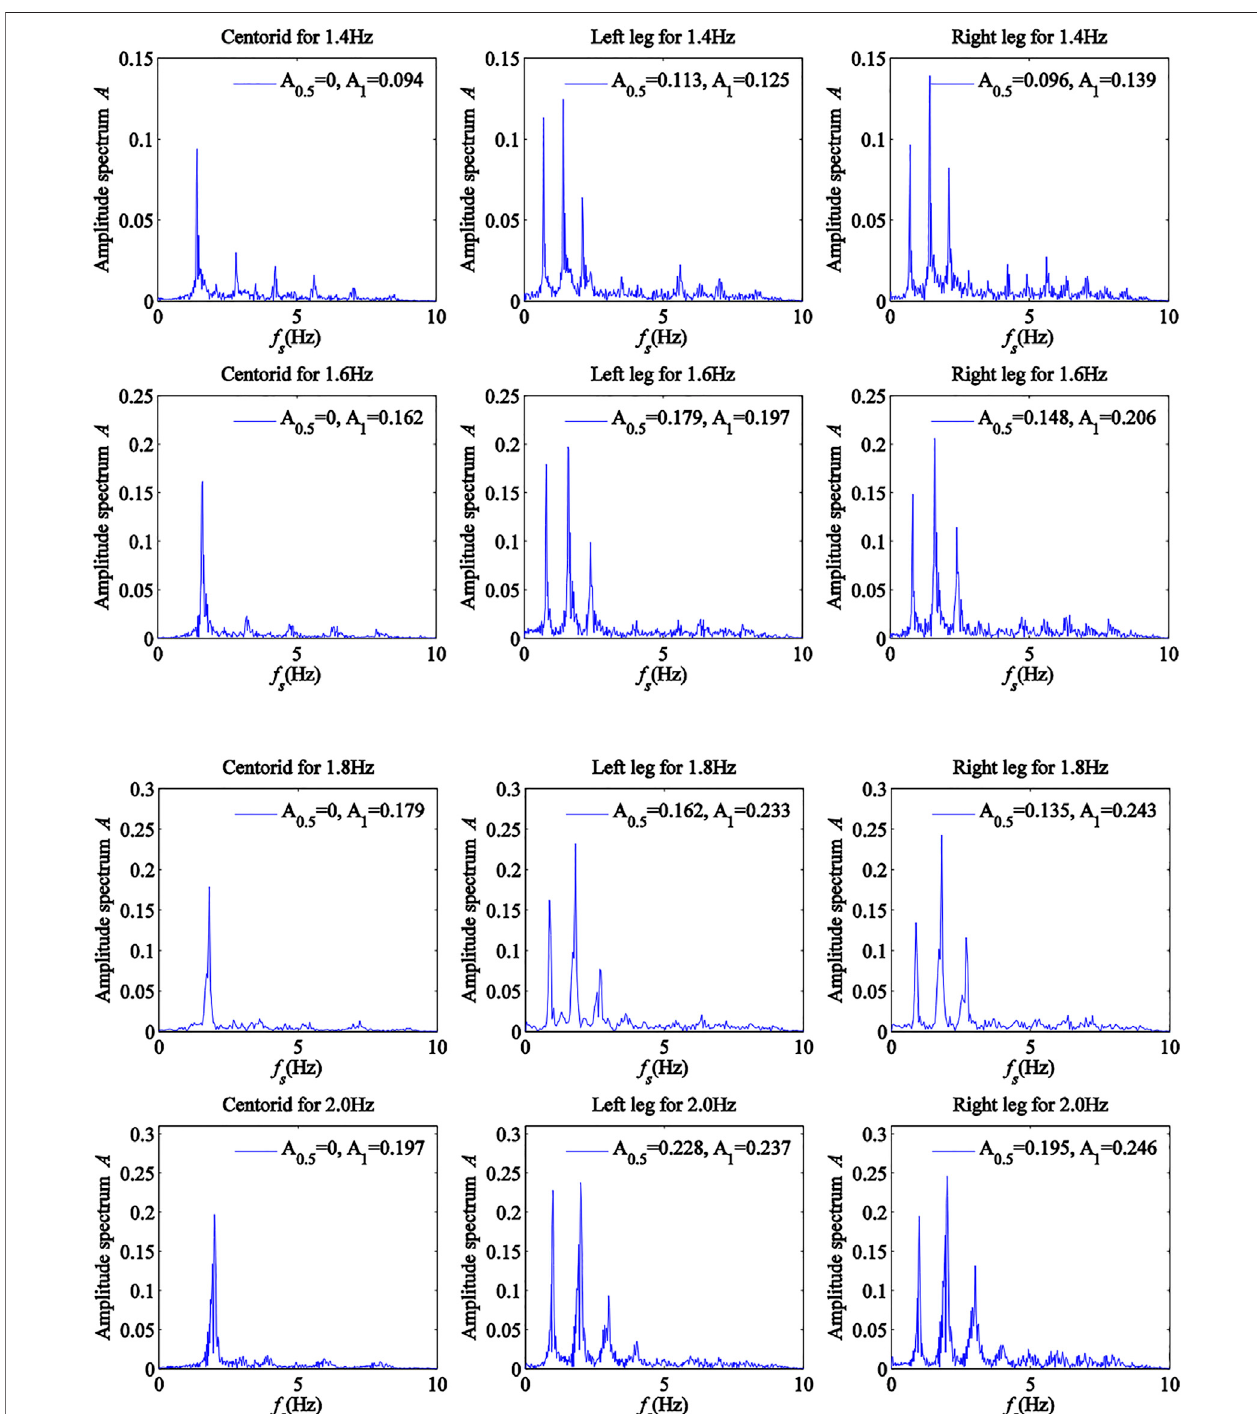
FIGURE 10 | Power spectra of pedestrian walking loads for stride frequencies f w of 1.4 and 2.0 Hz